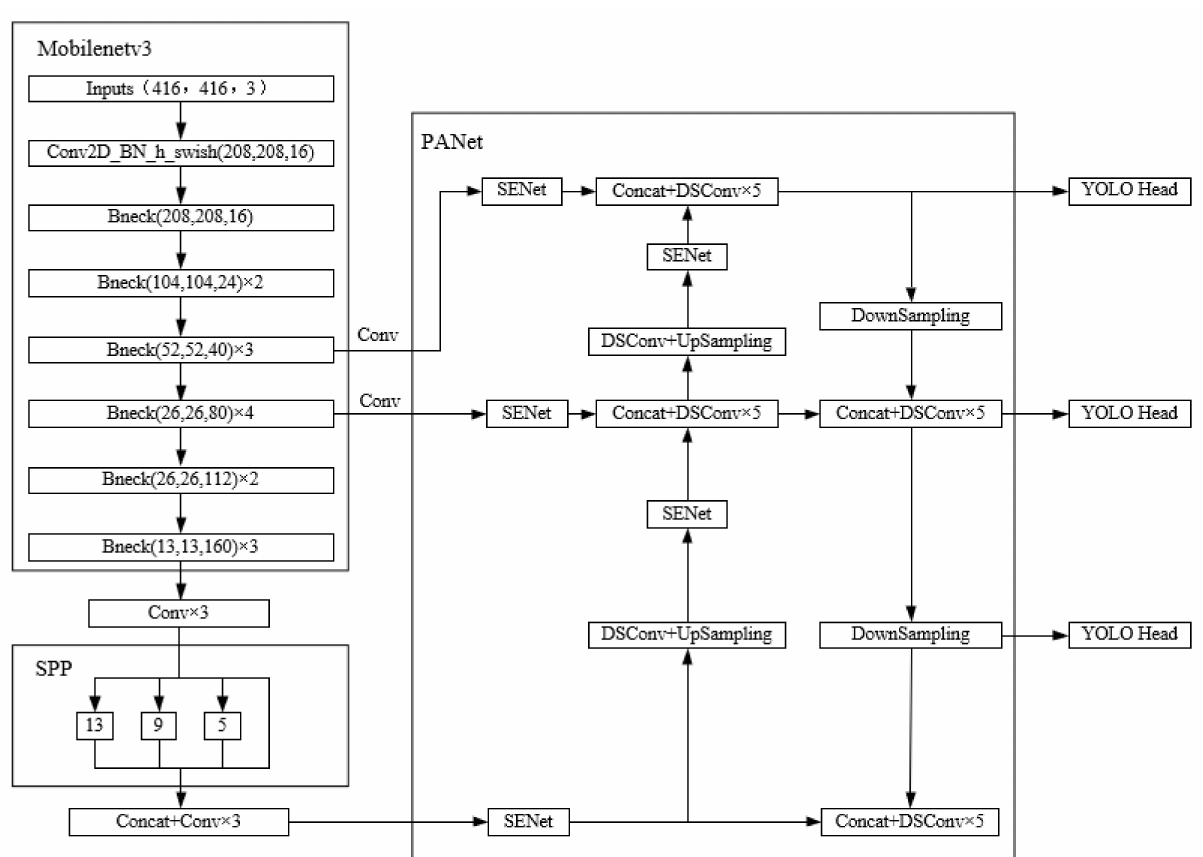
Figure 6. Framework of the improved YoloV4 network model. Conv2D_BN_h_swish represents a composite module with 2D convolution (Conv2D) plus bulk regular (BN) plus h_swish activation function; Conv represents convolution; DSConv represents deep separable convolution; Concat represents stack; UpSampling represents upsampling; DownSampling represents